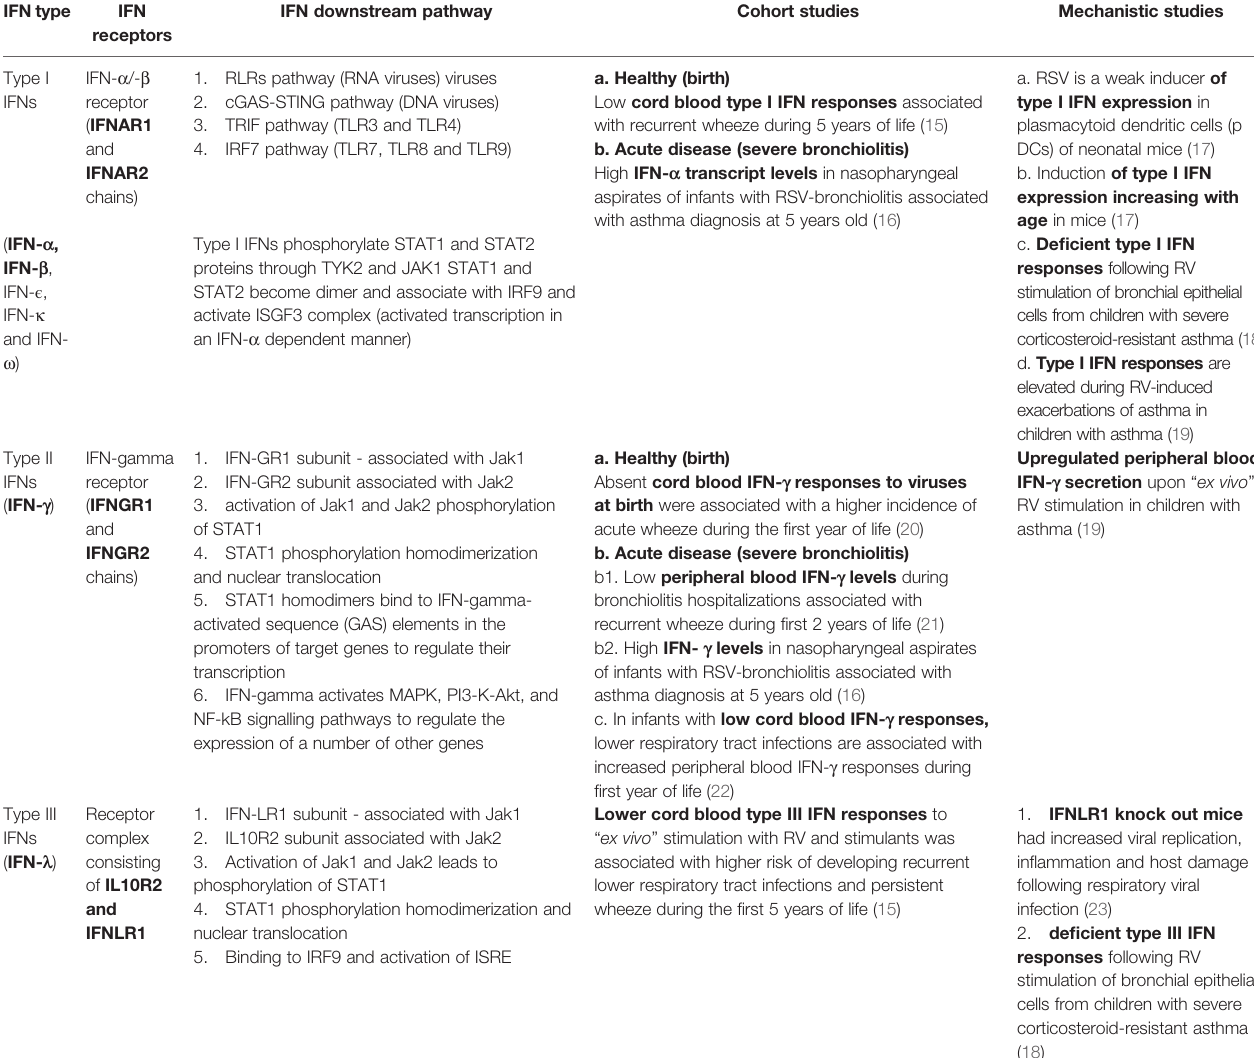
TABLE 1 | Interferon (IFN) types and their reported role in driving susceptibility to asthma following infant